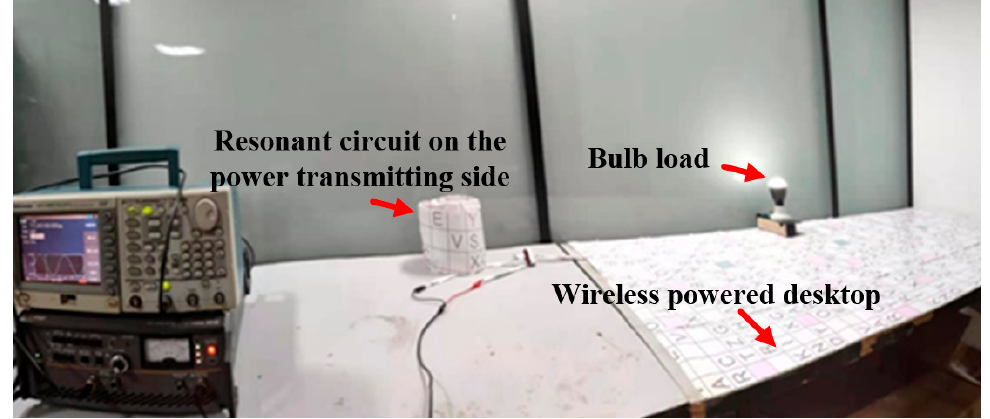
Figure 15. DWPT system experiment platform.